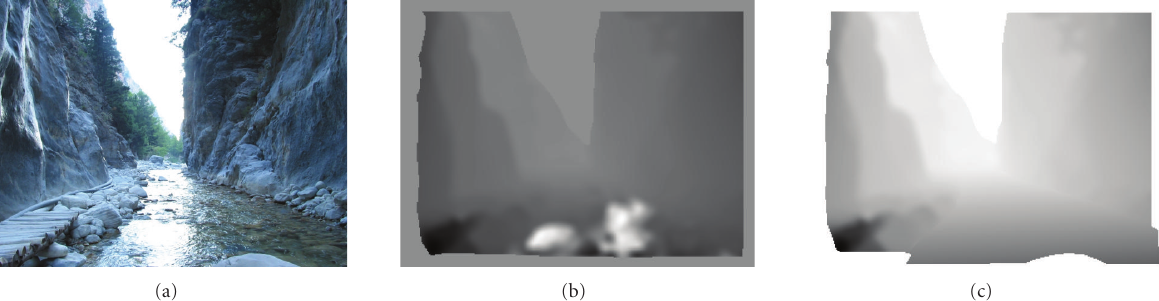
Figure 14: (a) The left image of a stereoscopic image pair that has been captured at a region passing through a small river. (b) The estimated disparity by using a stereo matching procedure. As expected, the disparity field contains a lot of errors for many of the points on the water surface. This is true especially for those points that lie near the sun reflections on the water. (c) The corresponding disparity when a 2D homography is being used to fill the left-right correspondences for the points on the water. In this case, the water surface is implicitly approximated by a 3D